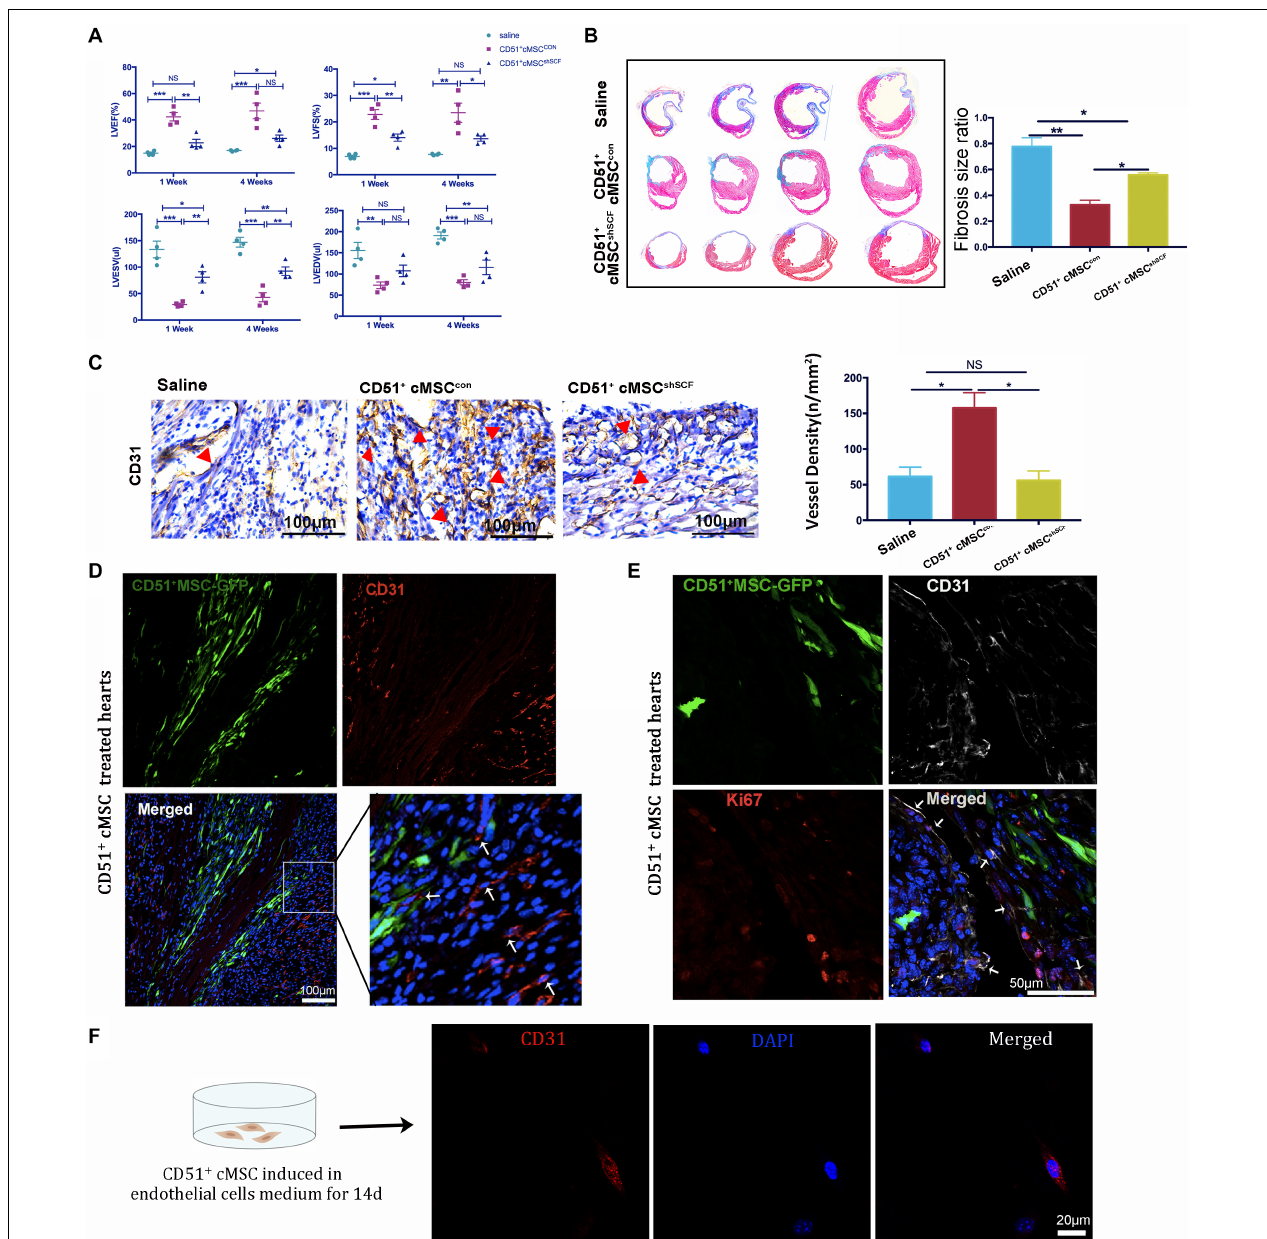
FIGURE 6 | CD51 + cMSC therapy improved heart function through SCF-mediated angiogenesis in vivo , n = 12 mice per group. (A) Analysis of echocardiography parameters at 1 and 4 weeks after treatment; LVEF, left ventricular ejection fraction; LVFS, left ventricular fractional shortening; LVESV, left ventricular end systolic volume; LVEDV, left ventricular end diastolic volume, n = 4. (B) Assessment of myocardial fibrosis using Masson’s trichrome staining 4 weeks after treatment; the fibrosis size ratio was presented as percentage of fibrosis length of the LV, n = 3. (C) Images of immunohistochemical staining with CD31 antibody in the infarcted myocardium 2 weeks after injury, the cone indicated the vessels, and values were presented as numbers of vessels per square meter, n = 3. (D) Representative images of immunofluorescence staining with CD31 antibody in the infarcted myocardium 7 days after treatment: GFP-positive CD51 + cMSCs (green); CD31 (red); DAPI (blue). (E) Immunofluorescence staining of the heart with AMI 1 week after CD51 + cMSC treatment: CD51 + cMSCs (green), CD31 (white), Ki67 (red), DAPI (blue); arrows indicated co-localization of CD31 and Ki67, scale bars 50 µ m. Data in all panels are presented as means ± SEM, NS: P > 0.05; * P < 0.05, ** P < 0.01, and *** P < 0.001. (F) CD51 + MSCs were cultured in the endothelial cell medium for 14 days and stained with